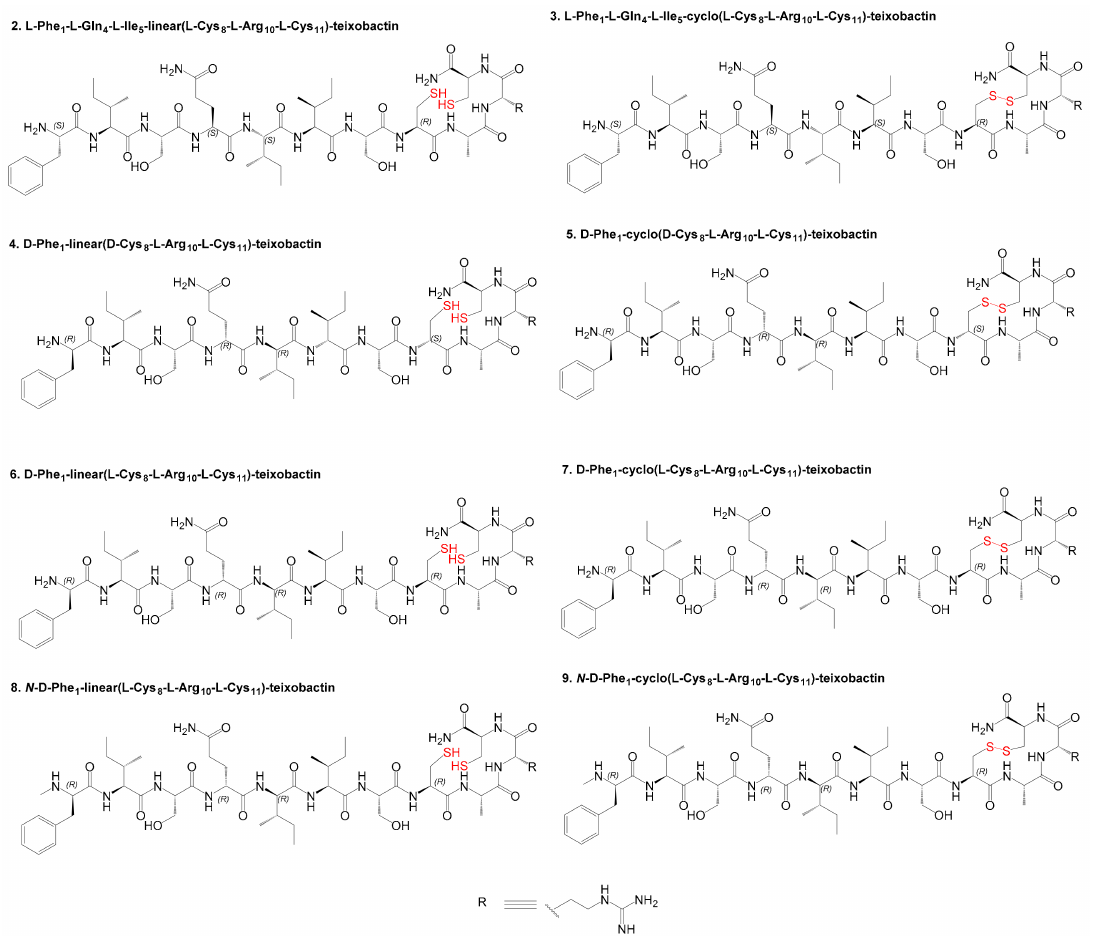
Figure 2. Structure of teixobactin analogues, 2 – 9